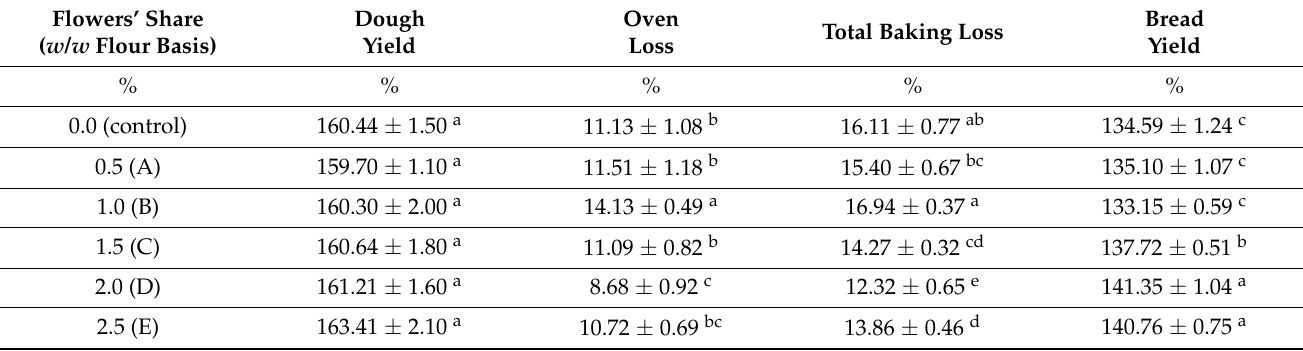
Table 1. The parameters of laboratory baking process of wheat bread enriched with J. regia male